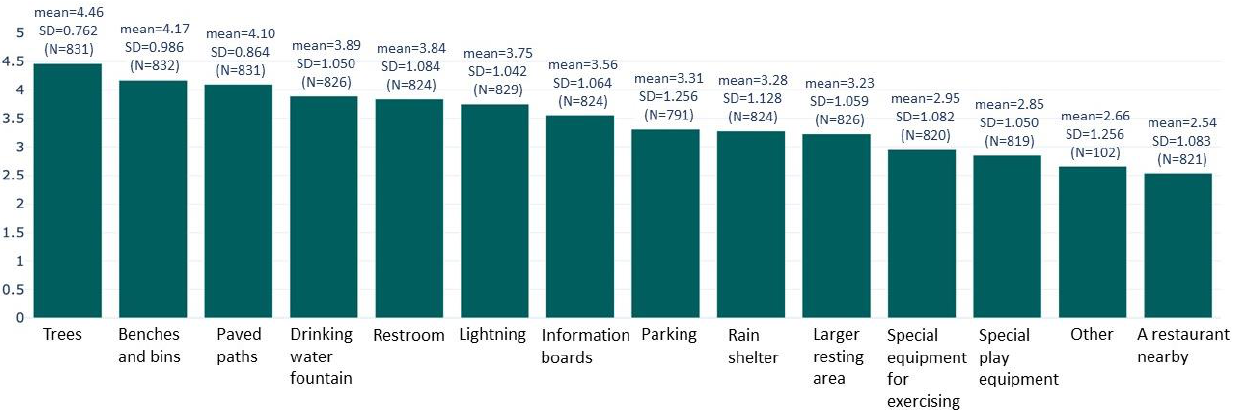
Figure 6. Equipment of Green Spaces, Important to Respondents for their Physical Activity. Note: Missing values are excluded from the calculation.